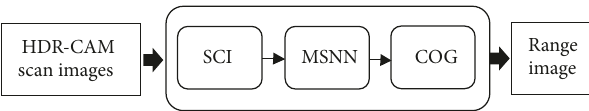
Figure 22: Data flow graph for processing images from HDR-CAM.